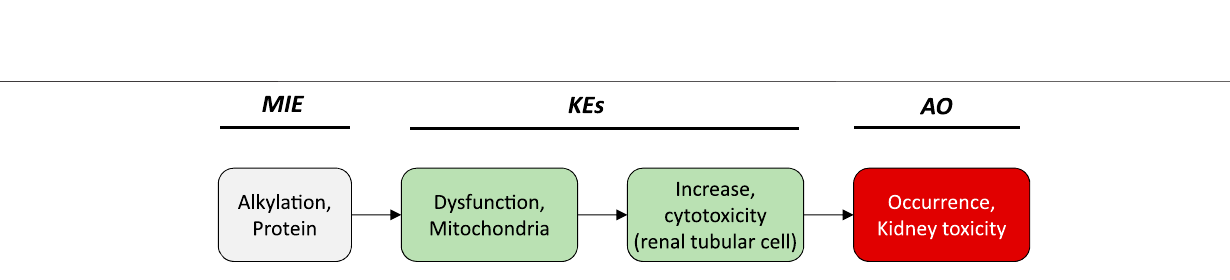
Frontiers in Toxicology |